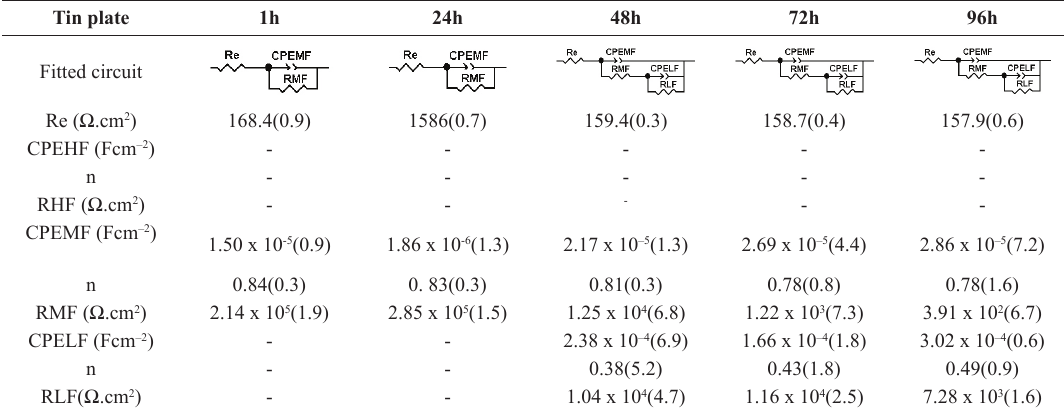
Table 3. Electrical elements fitted values for tin plate up to 96 h of immersion in a 0.05M NaCl solution. The error % associated with each parameter value is given in parenthesis. Tin plate Fitted circuit